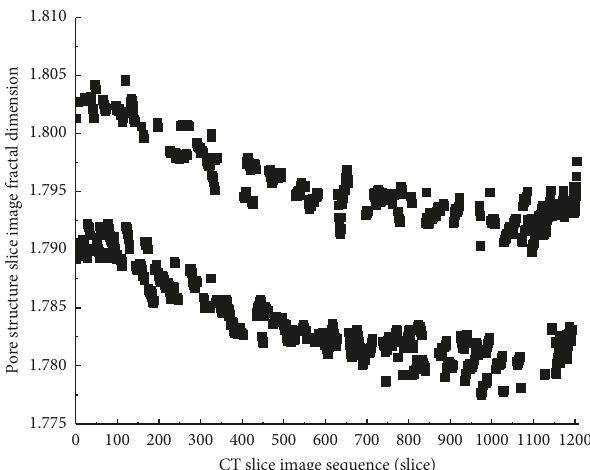
Figure 7: Statistical analysis of fractal dimension of the CT slice image of the aerated concrete block sample.